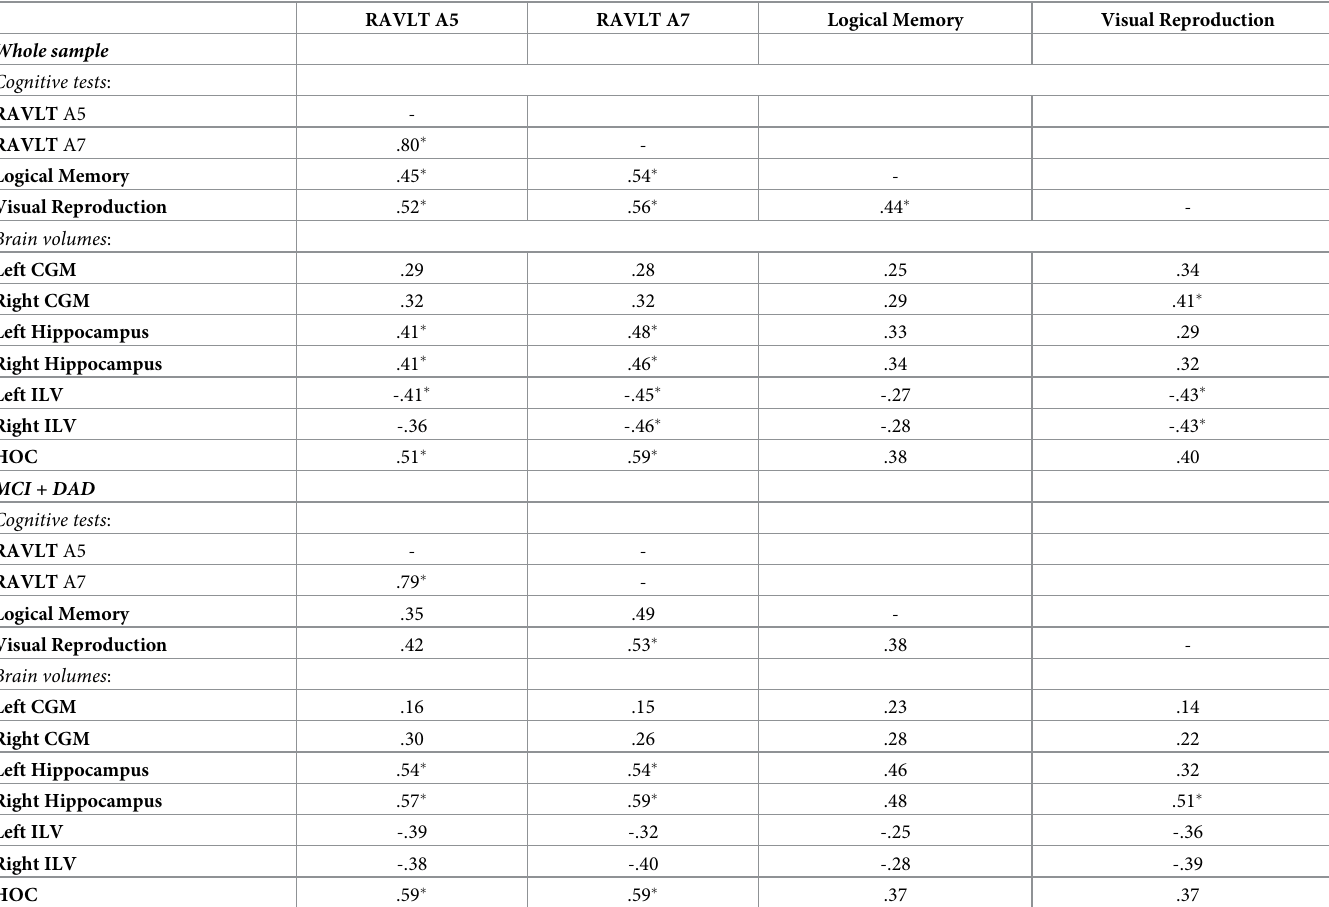
Table 2. Partial correlations among scores in cognitive tests and brain volumes (corrected for intracranial volumes), controlling for age and